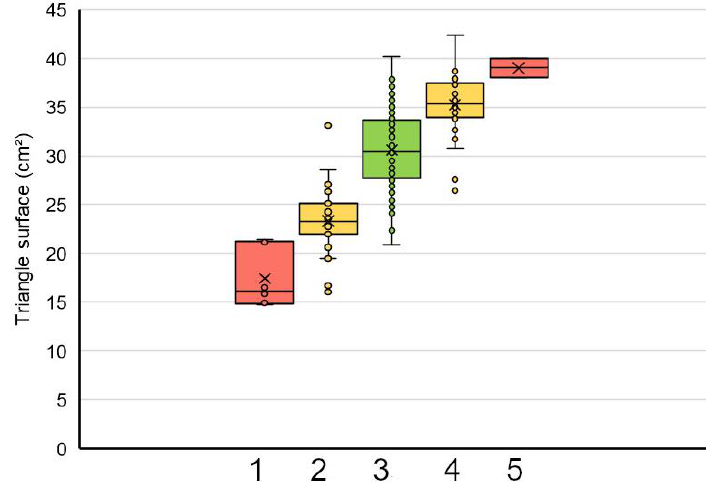
Figure 8. Triangle surface (cm 2 ) scaled according to the groups calculated from body weight: length